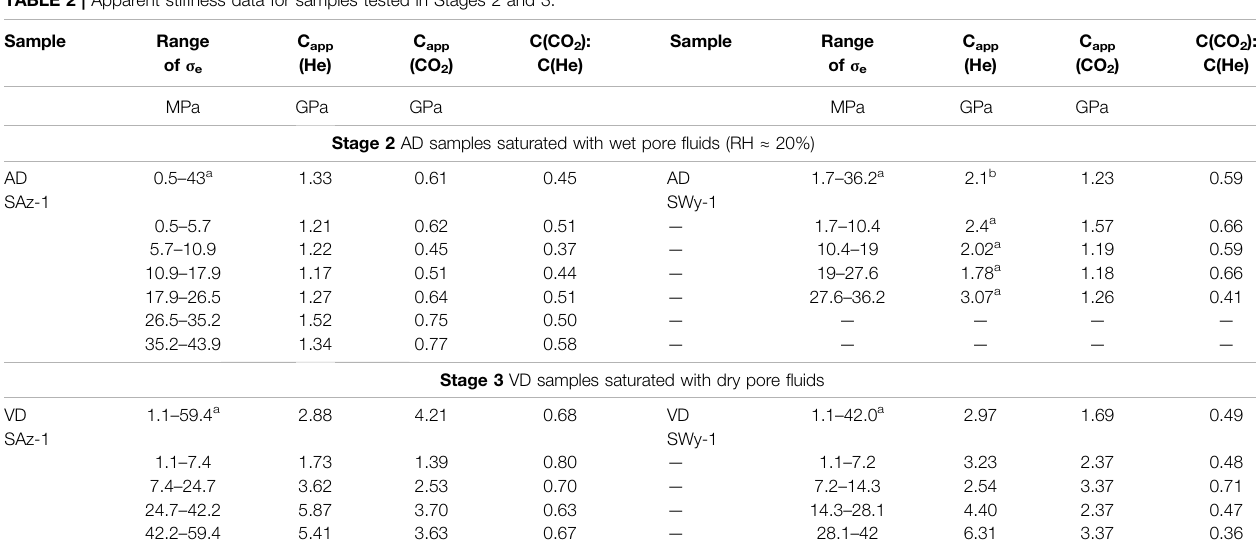
TABLE 2 | Apparent stiffness data for samples tested in Stages 2 and 3.